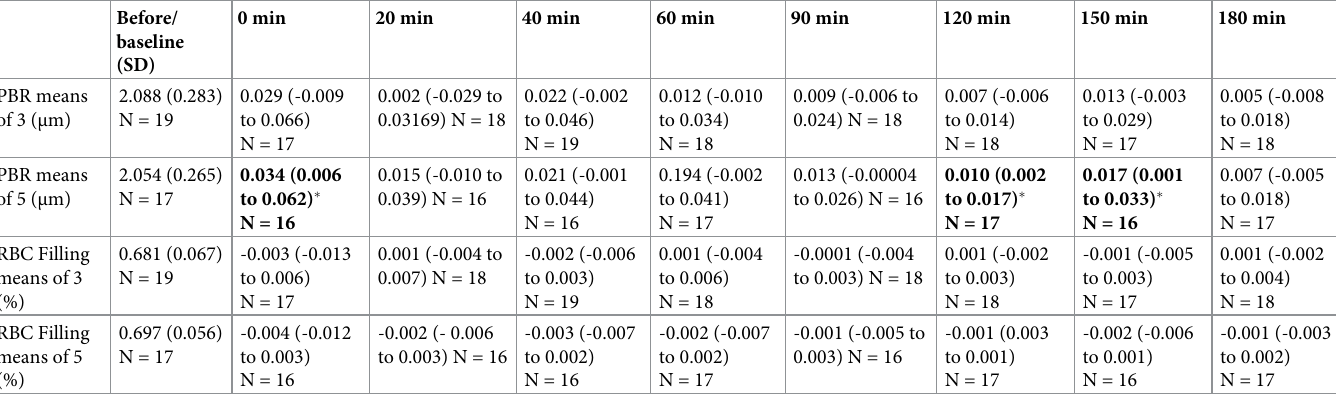
Table 3. Results of no intervention before and at times 0–180 min. Before/